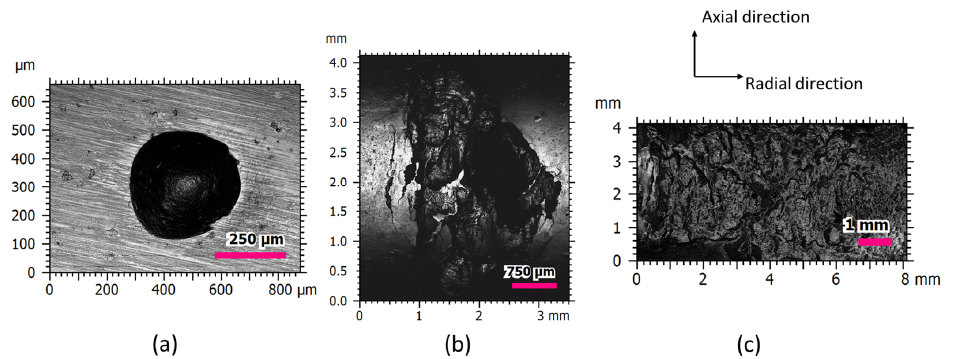
Figure 6. The characterization of running bearing defects. ( b , c ) are defects grown from ( a ) indentation with increasing running cycles under the same condition. Measurement were performed by Sensofar S Neox, with an objective of 20×, restoration applied and no filtering applied.